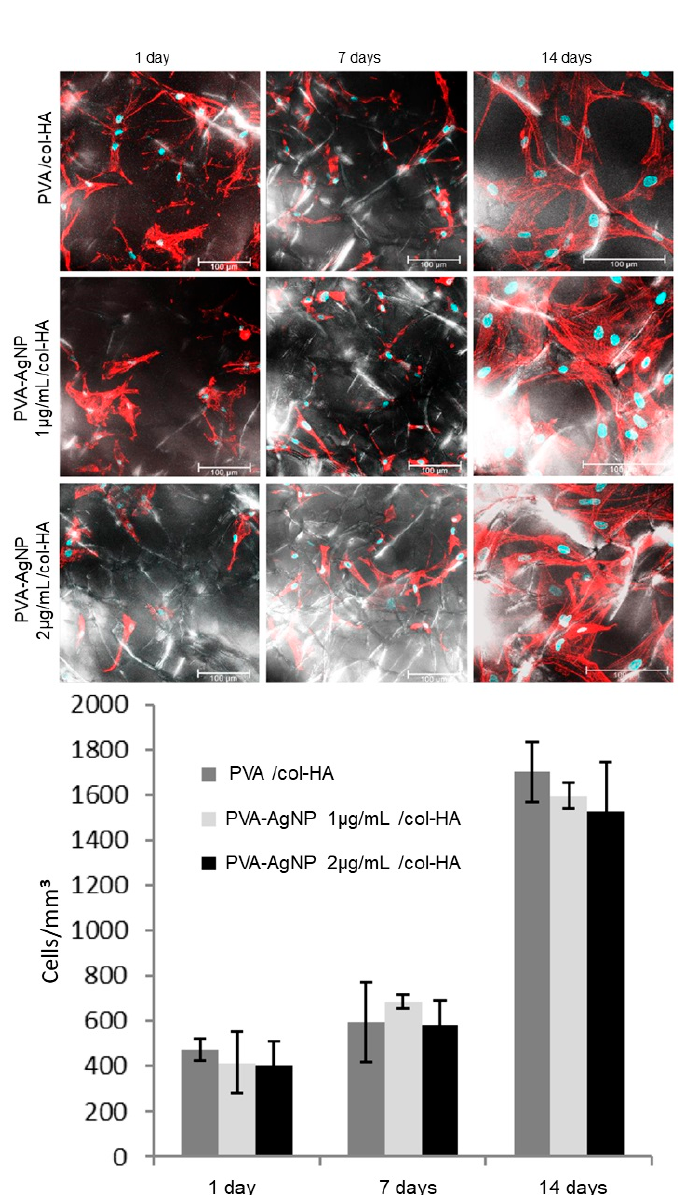
Figure 5. LSCM images of hMSCs adhered to PVA/col-HA containing or not AgNP at two concentrations. Images are shown as merged optical planes from the surface to a 100 µm depth reconstructed area. Bright/Dark background identifies the collagen distributed fibers shown by the confocal PMT-TRANS mode. The assorted polygonal-shaped cell morphology follows the random collagen distribution. Cell nuclei are identified by DAPI (blue) and actin cytoskeleton by Alexa Fluor 488 (red). The graphic shows the total cell count per area. Values are expressed as mean and standard deviation of a quintuplicate. No statistical significance was identified between groups of the same period. Bars 100 µm.